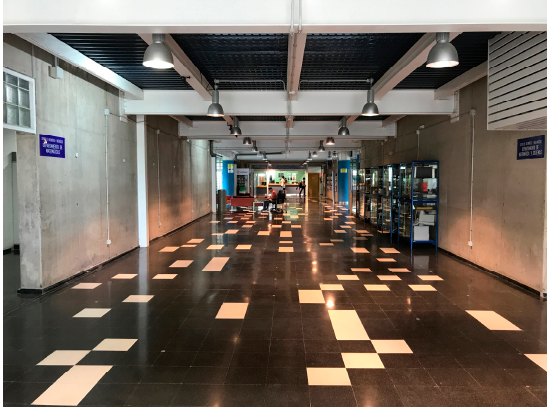
Figure 5. View of the first scenario where TB1 is located.